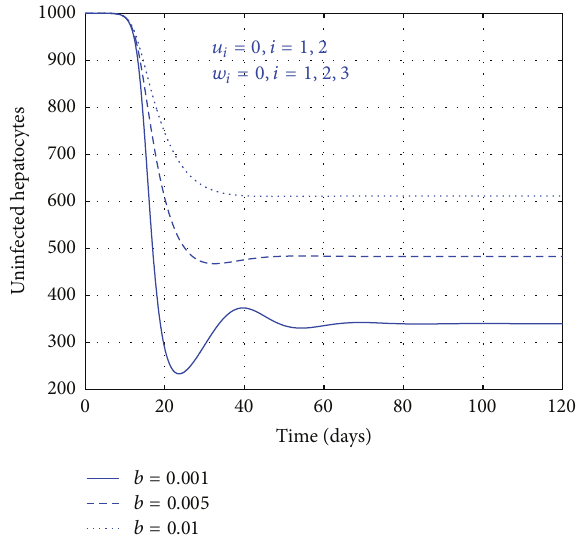
Figure 1: The evolution of uninfected hepatocytes for untreated case.